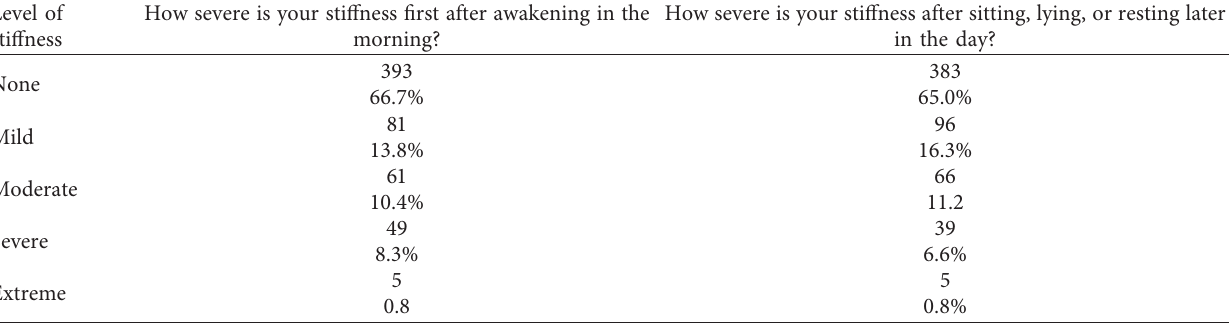
Table 4: Determination of prevalence of joint stiffness at different